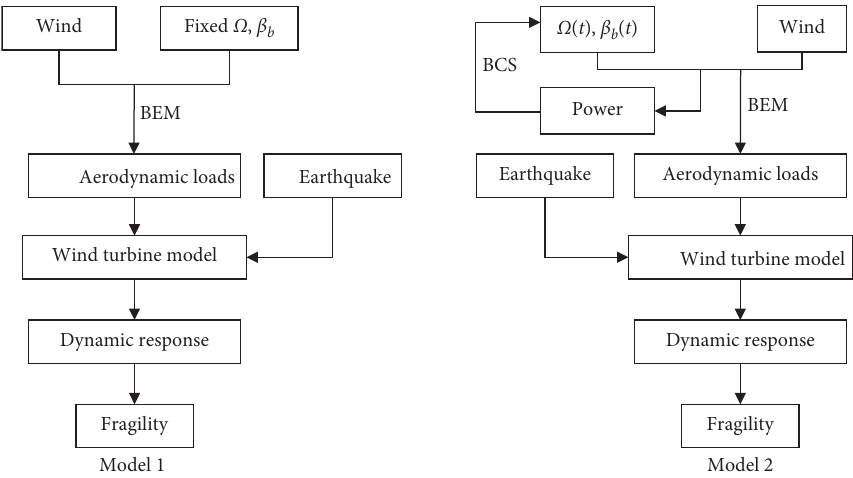
Figure 1: Flowchart of the two computational models. Table 1: Properties of 5MW NREL wind turbine